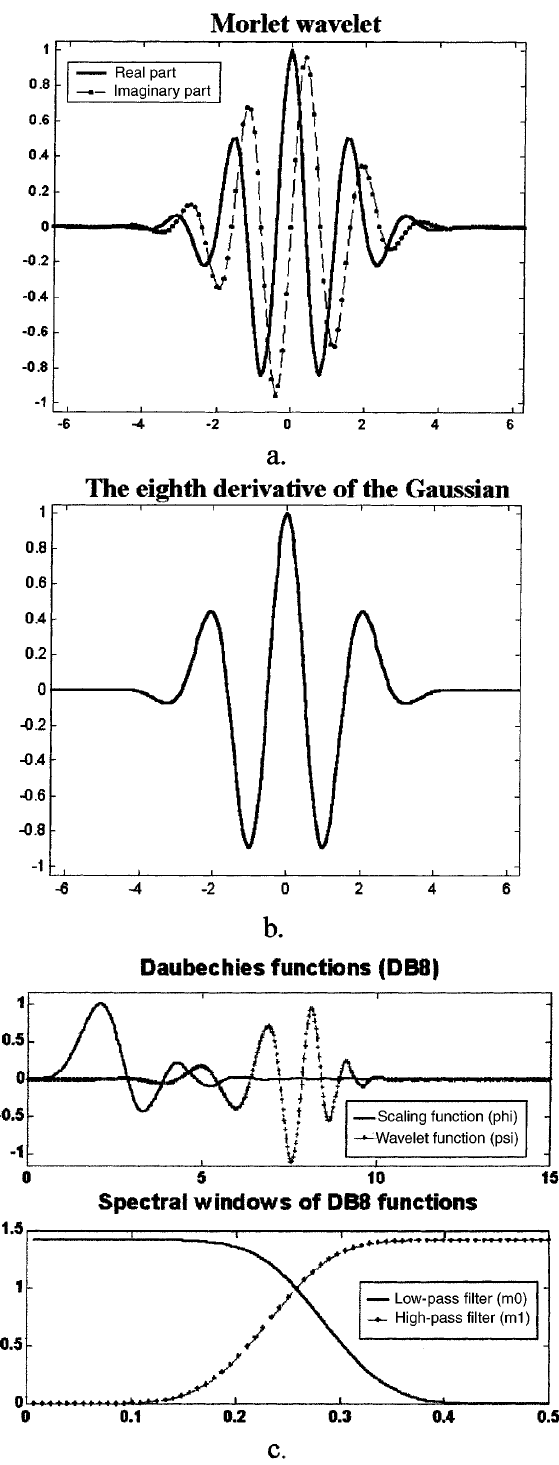
Fig. 2a–c. Analyzing wavelets used in the CWT and the multireso- lution analysis: a the Morlet complex-valued wavelet; b the eighth derivative of the Gaussian; c the eighth order Daubechies functions: the ‘scaling and wavelet functions’ ( upper panel ), and corresponding spectral windows ( lower